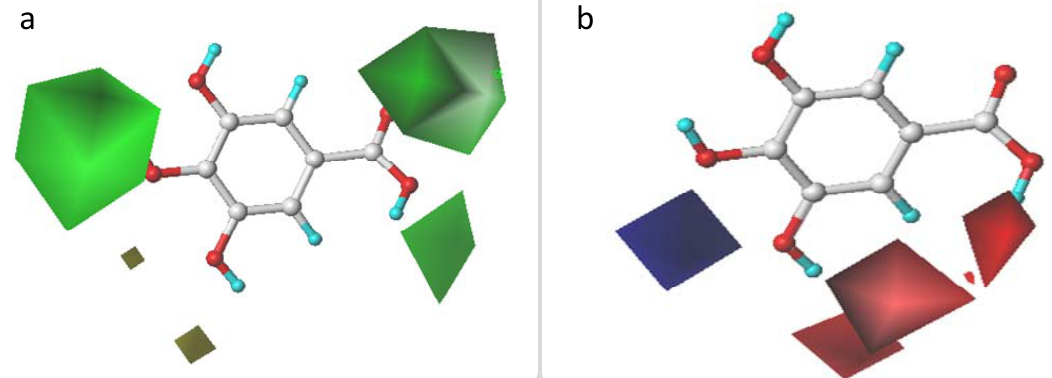
Figure 1. CoMFA contour maps. ( a ) steric contour map: the green is sterically favored for the activity , whereas the yellow is unfavorable; ( b ) electrostatic contour map: the blue contour for positive-charged substituent is favorable, whereas the red contour for the negative-charged substituent is